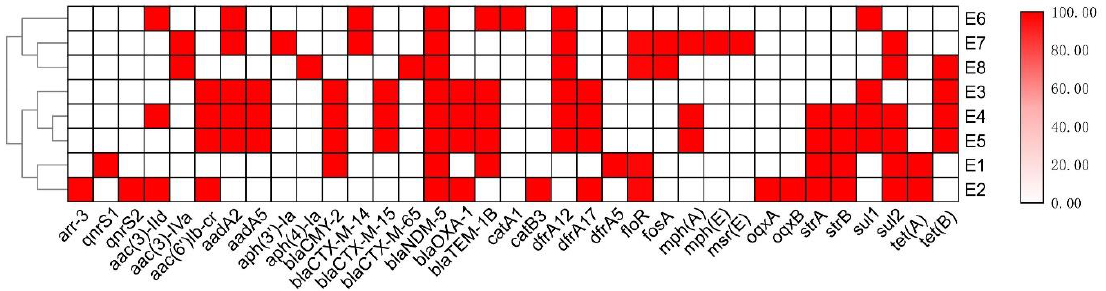
Figure 2. Heatmap of antimicrobial resistance genes carried by E. coli isolates in this study. The horizontal axis represents the antimicrobial resistance genes, and the vertical axis represents the strain IDs. The red boxes represent the presence of the corresponding items among the sequenced isolates, and the white boxes represent their absence. The gradient identity bar indicates the percentage similarity of related genes. The similarity tree was constructed using agglomerative hierarchical clustering, with the degree of similarity between different clusters calculated by the average linkage method and the degree of similarity of different isolates (calculated using the Spearman’s rank correlation coefficient).The classes of antibiotics to which the genes confer resistance included